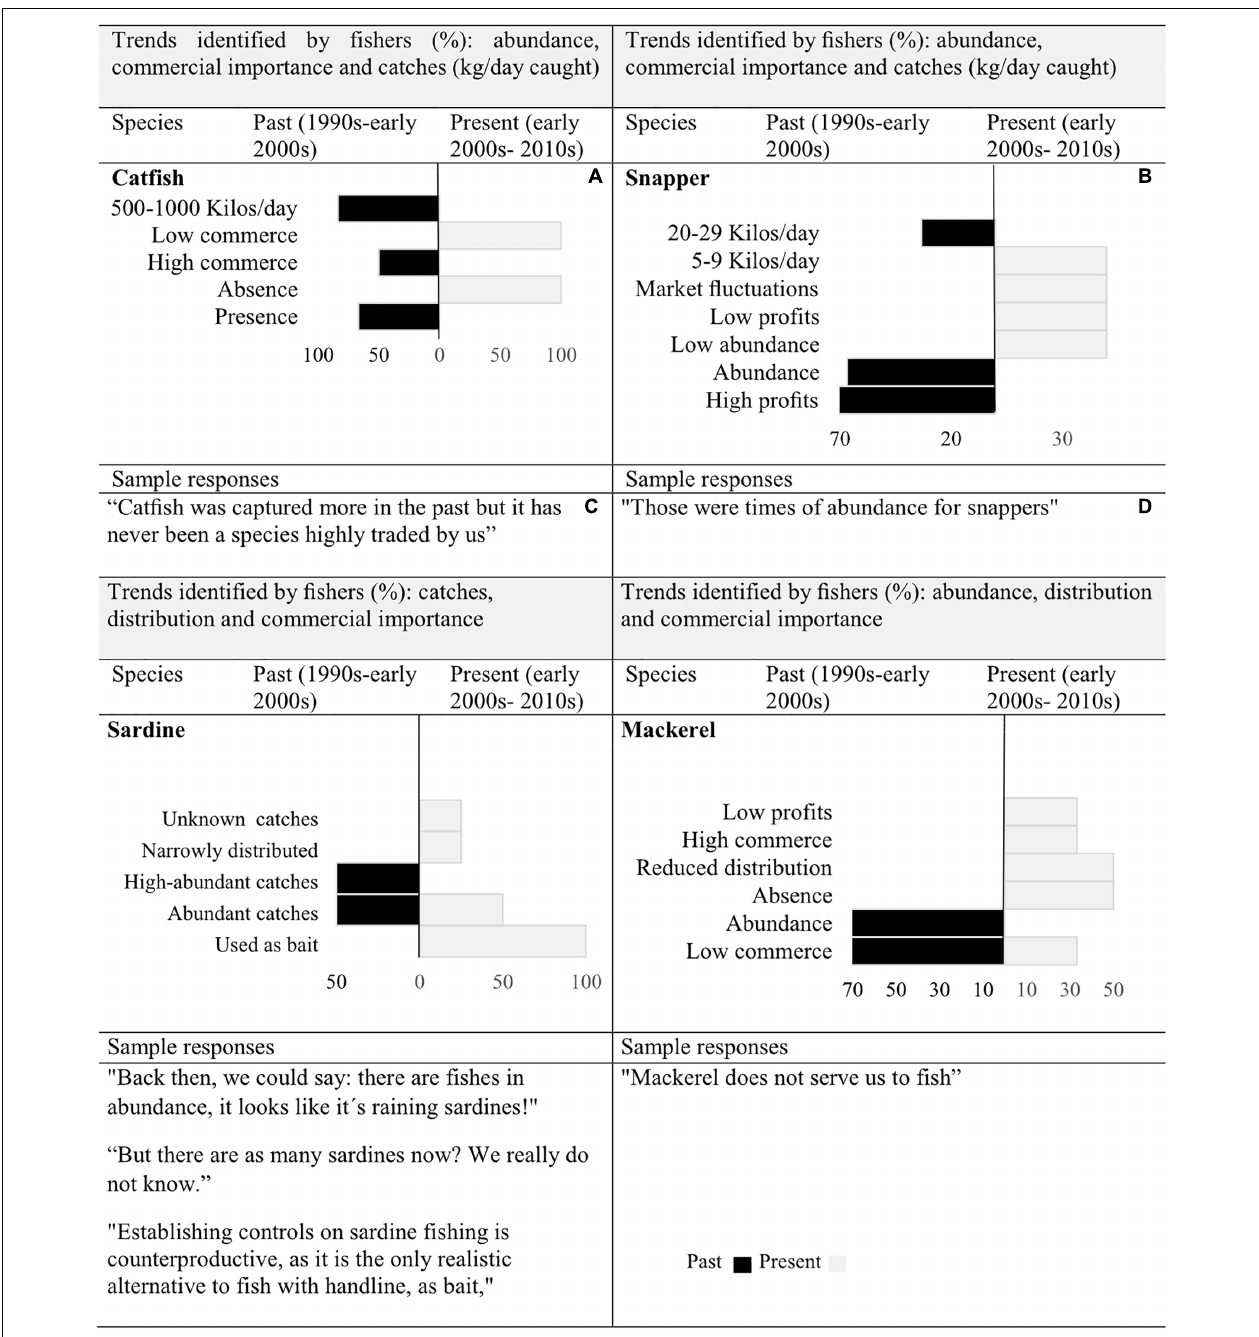
FIGURE 4 | Summary trends of four important commercial species in GoN as reported in the focus groups by participants: (A) catfish, (B) snapper, (C) sardine, and (D) mackerel (% of